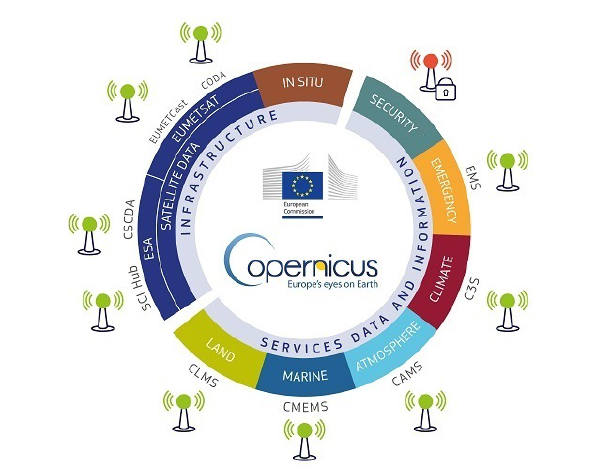
Figure 1. Copernicus Infrastructure and Services (Copernicus,